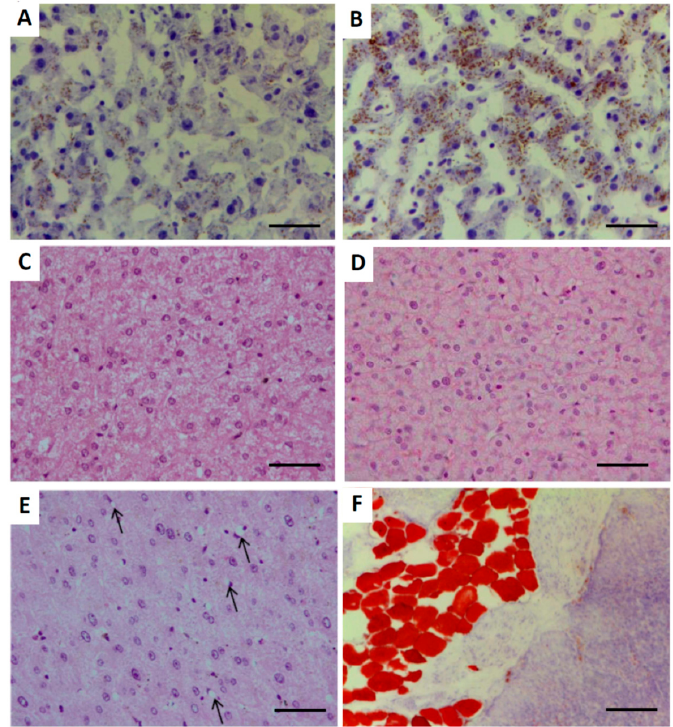
Figure 2. Histological images of liver and pancreas in obese sows. Upper pictures represent mild ( A ) and moderate ( B ) infiltration of lipids, stained in red, in the liver (oil red-O, 400×) Bar 50 µm. Pictures ( C ) and ( D ) of the liver represent mild and severe hydropic degeneration, respectively, whilst picture E exemplifies increased presence of lipocytes or Ito cells indicated with arrows (hematoxylin-eosin HE, 400×) Bar 50 µm. Picture F represents infiltration of adipocytes with intracytoplasmic accumulation of lipids, stained in red, in the pancreas (oil red-O, 100×) Bar 200 µm.